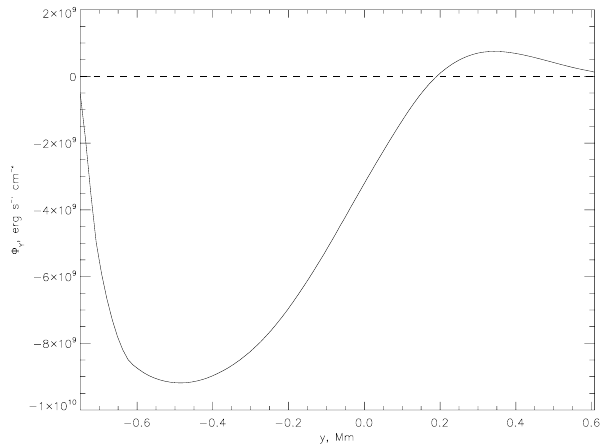
Fig. 6. Dependence of the mean vertical component of the Poynting flux vector on the height in the photosphere.